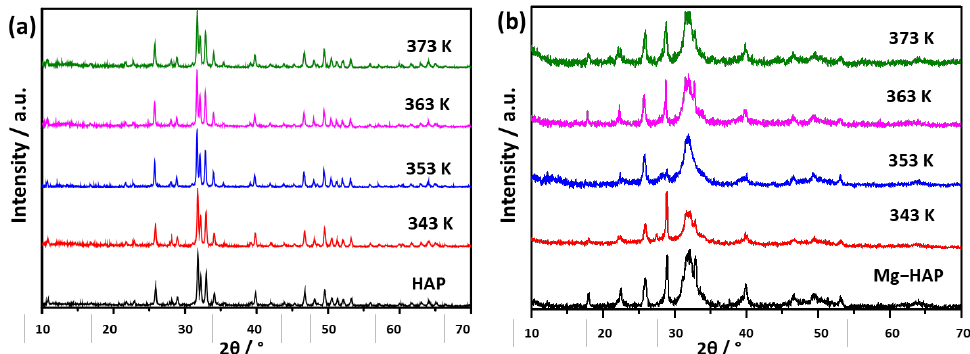
Figure 6. PXRD patterns of ( a ) non-substituted hydroxyapatite (HAP) and ( b ) Mg-substituted HAP (Mg-HAP) irradiated to 25 kGy after heating at 343 K, 353 K, 363 K and 373 K for 2 h.